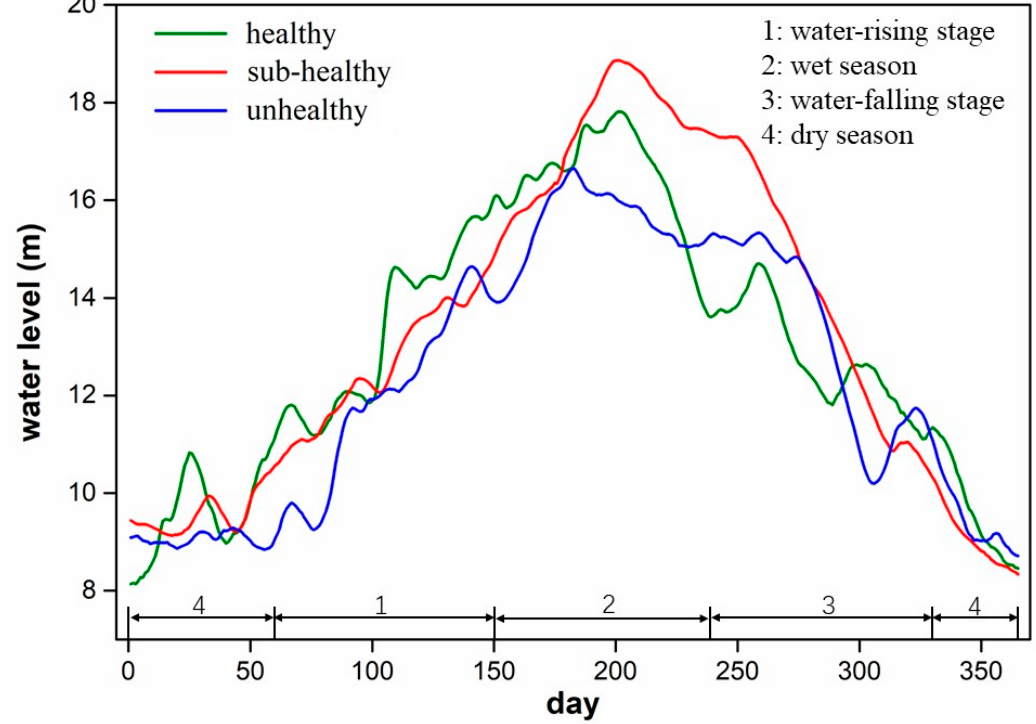
Figure 7. Water level fluctuation with different health status.